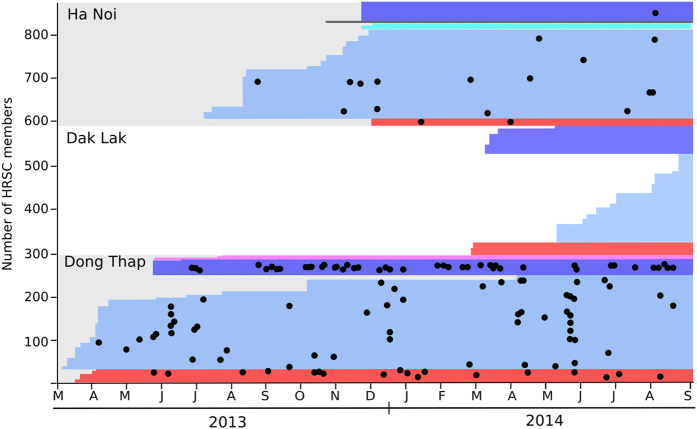
Graphical representation of person-time followed up for the HRSC members. Each horizontal line represents the person-time experience of one HRSC member.A black dot (∙) represents a reported episode of disease in one HRSC member. Colour code: dark blue: slaughterers; acqua: restaurant workers; pale blue: farmers; dark red: animal health workers; pink: rat traders.